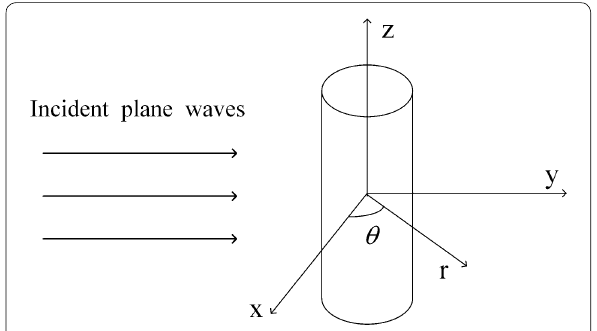
Figure 1 Scattering of plane wave for a